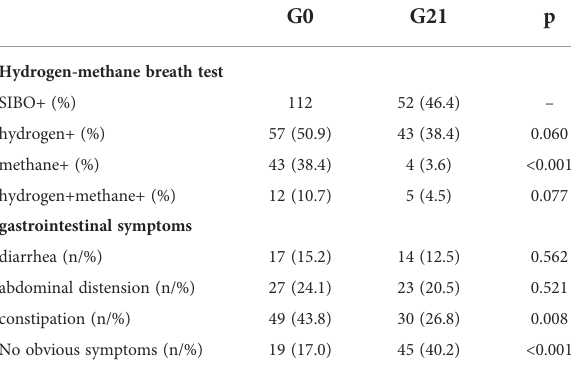
TABLE 5 Positive rates of pure hydrogen, pure methane and hydromethane in the G0 and G21 groups.